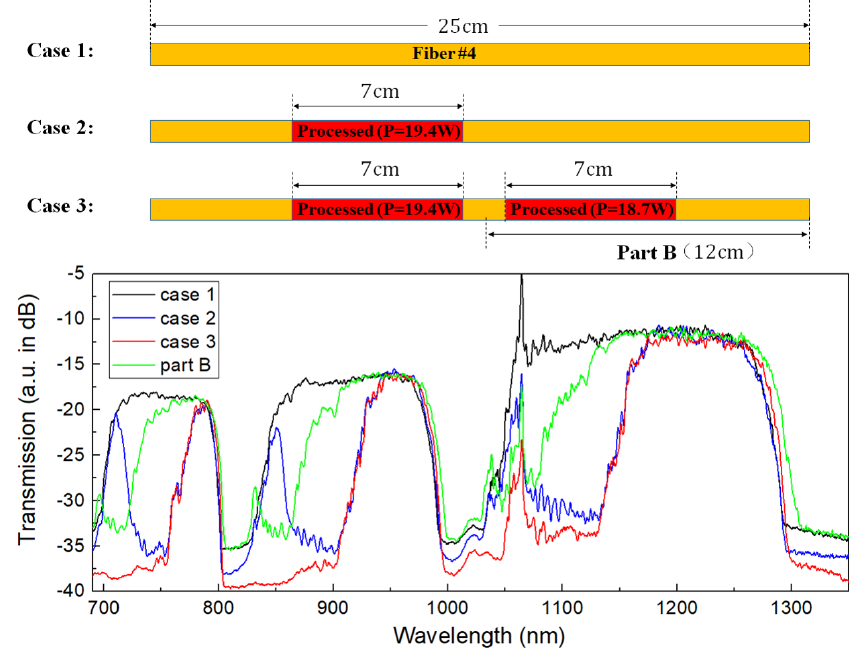
Figure 7. Schematic diagram illustrating the steps to make an HC-ARF-based band pass filter. As multiple different wall thicknesses are “written” into the original HC-ARF, the transmission bands are greatly narrowed.